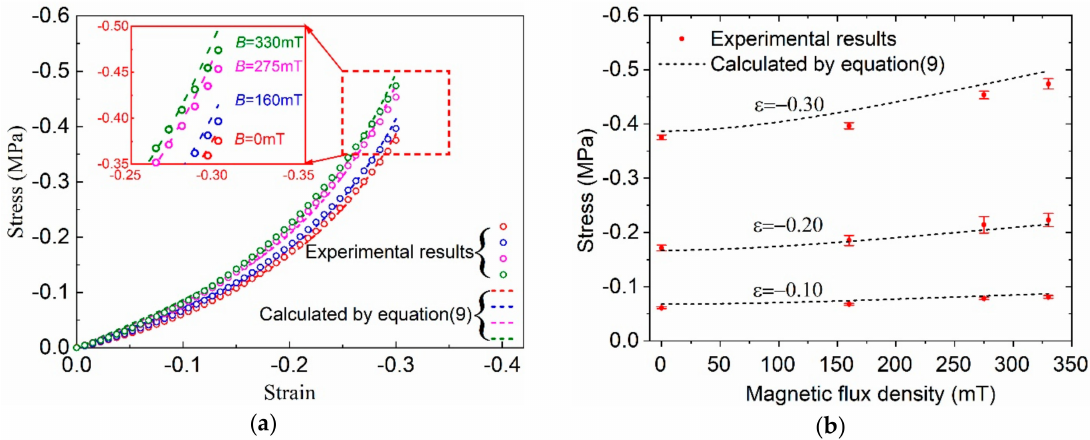
Figure 6. Comparison of the stresses calculated by the magneto-hyperelastic model (Equation (9)) with experimental results: ( a ) stress-strain curves under di ff erent magnetic flux densities; ( b ) stress as a function of the magnetic flux density at di ff erent